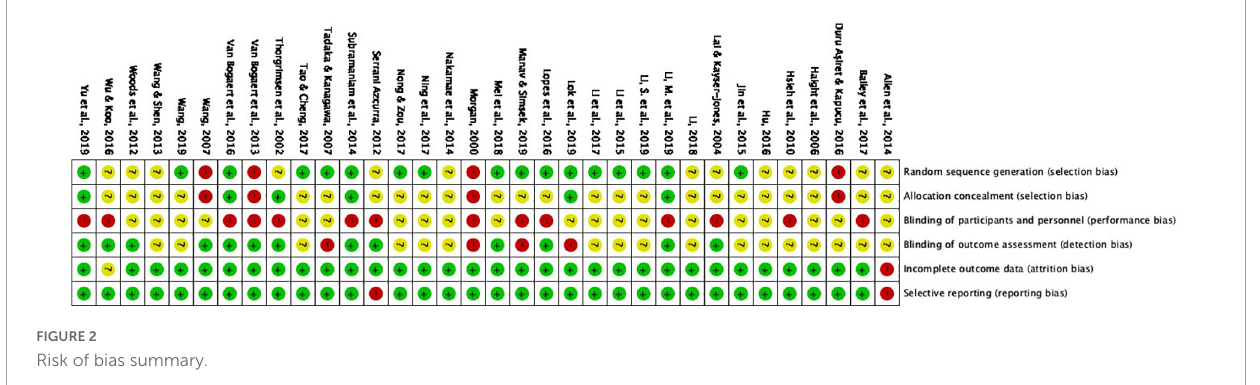
FIGURE2 Risk of bias summary.